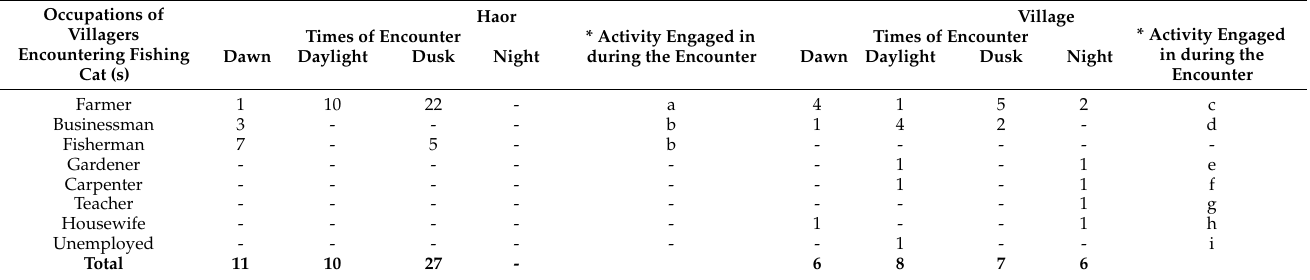
Table 1. Difference in time and activity engaged during encounters between the haor and village areas. Both daytime and nighttime encounters were reported in villages. Diurnal encounters dominated in the haor.